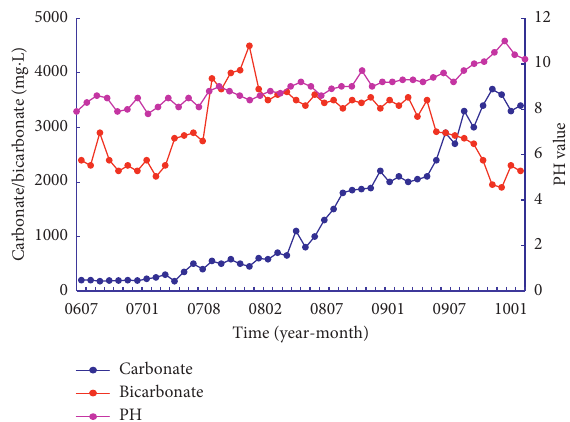
Figure 12: SASP produced fluid ion concentration [80].